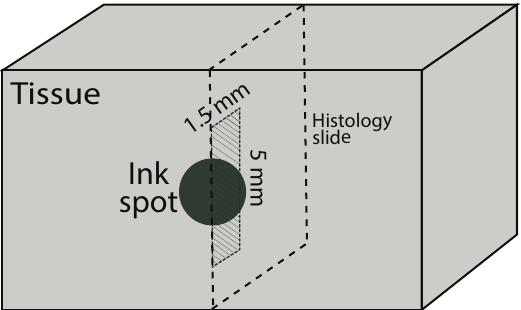
Figure 6. Illustration showing the orientation of the histology section taken at the location of a black ink spot. The 1.5-mm by 5.0-mm region beneath the ink spot marks the area assessed during histological analysis of the section.